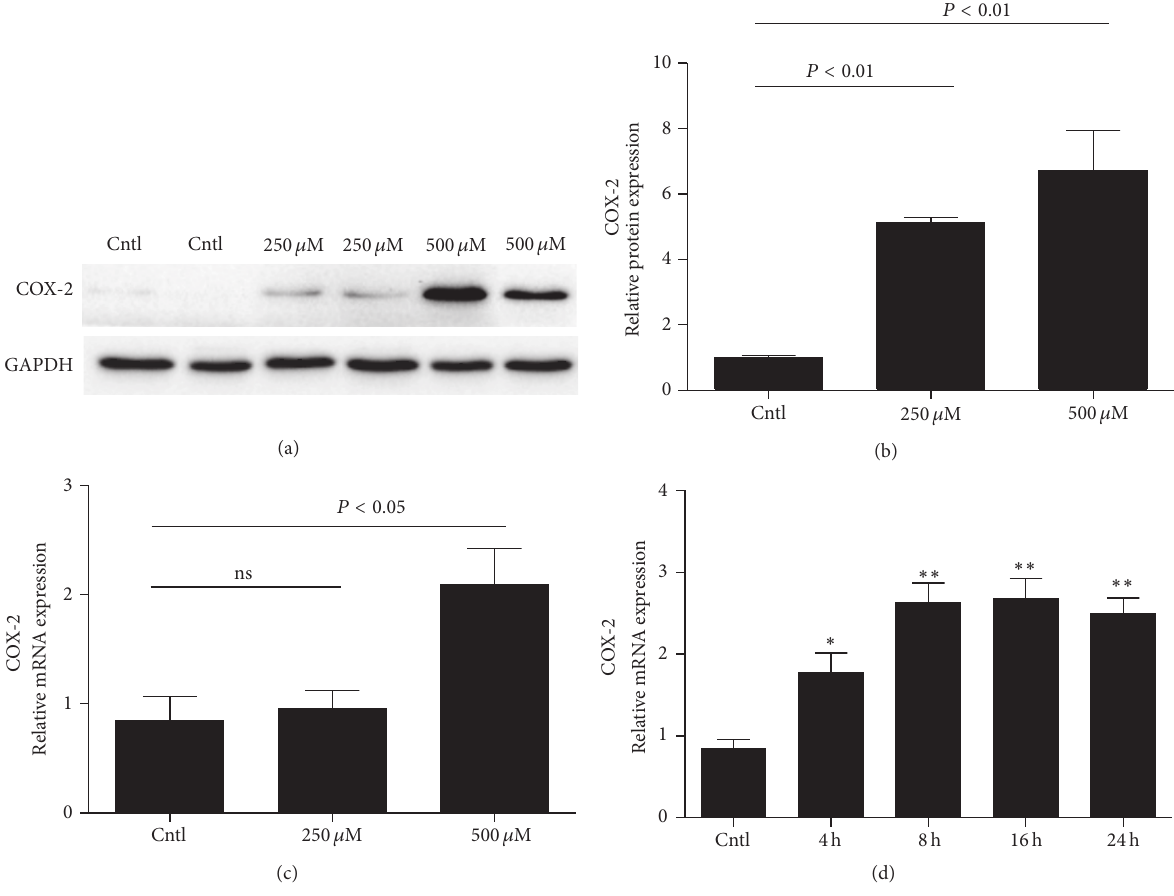
Figure 4: Expression of COX-2 in IS-induced mouse MCs. MCs were treated with the indicated doses of IS (0, 250, and 500 𝜇 M) for 24 h and then COX-2 protein (a and b) and mRNA (c) and protein expressions were analyzed by Western blotting and qRT-PCR. A time course analysis of COX-2 mRNA expression following IS treatment at a dose of 500 𝜇 M was also examined (d). Values are means ± SD; 𝑛 = 6 in each group; ∗ 𝑃 < 0.05 versus control and ∗∗ 𝑃 < 0.01 versus